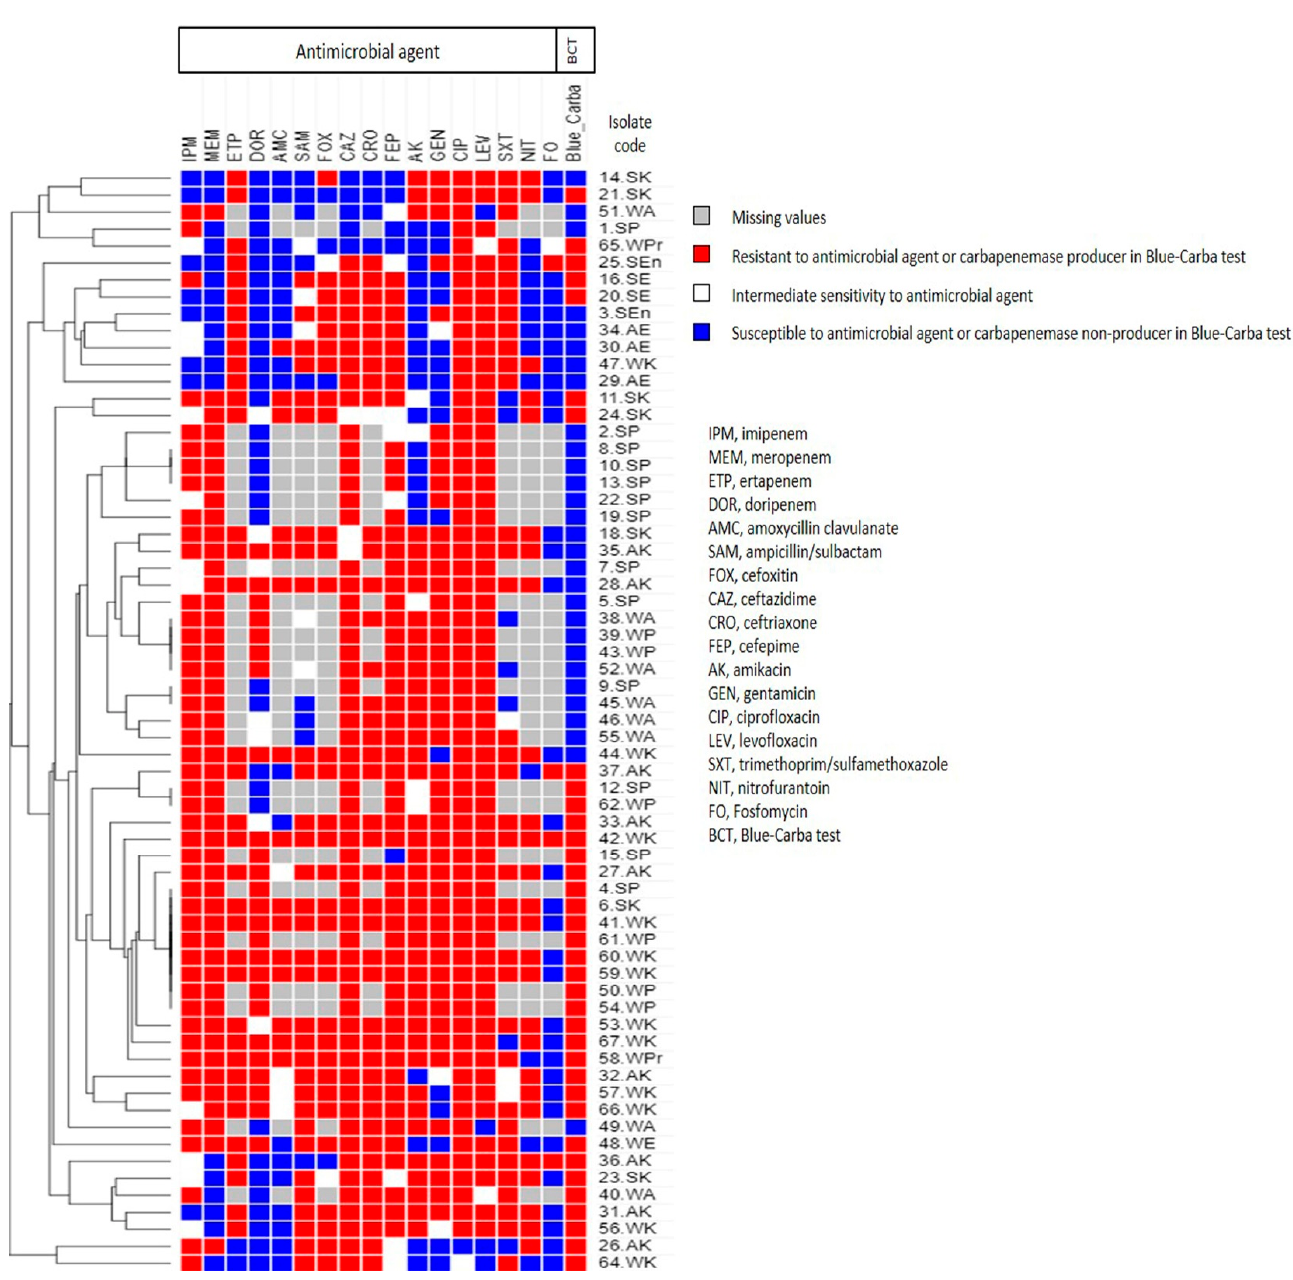
Figure 2. Heatmap of carbapenem-resistant Gram-negative bacterial isolates ( n = 65) in this study based on their antimicrobial resistance patterns and carbapenemase enzyme production (Blue-Carba test results). This heatmap was generated by using Morpheus online software using Euclidean distances (https://software.broadinstitute.org/morpheus/, accessed on 15 April 2021).